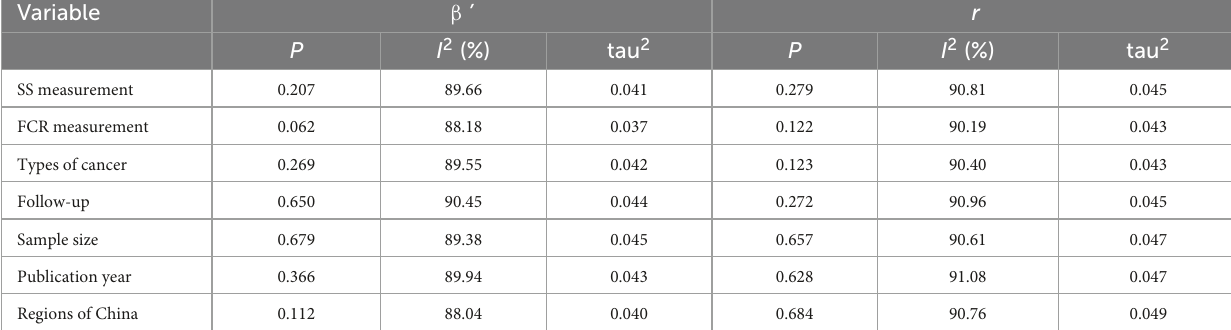
TABLE 3 Meta-regression analysis of the summary r coefficient between social support (SS) and fear of cancer recurrence (FCR).